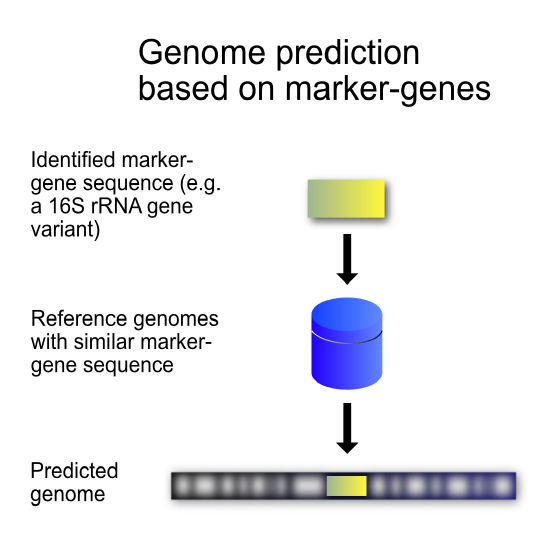
Figure 3: Genome prediction based on marker-gene sequences . This is another method of producing joint taxa and function profiles, which in this case are explicitly linked, similar to assembling genomes. This is also the first step in most metagenome prediction workflows. However, all such genome prediction methods are highly biased towards the specific reference genomes used for prediction. In addition, they can only predict genome content to the level at which the chosen marker-gene differs between closely related taxa. This is a major limitation as many strains of bacteria with highly divergent genome content have identical marker-gene